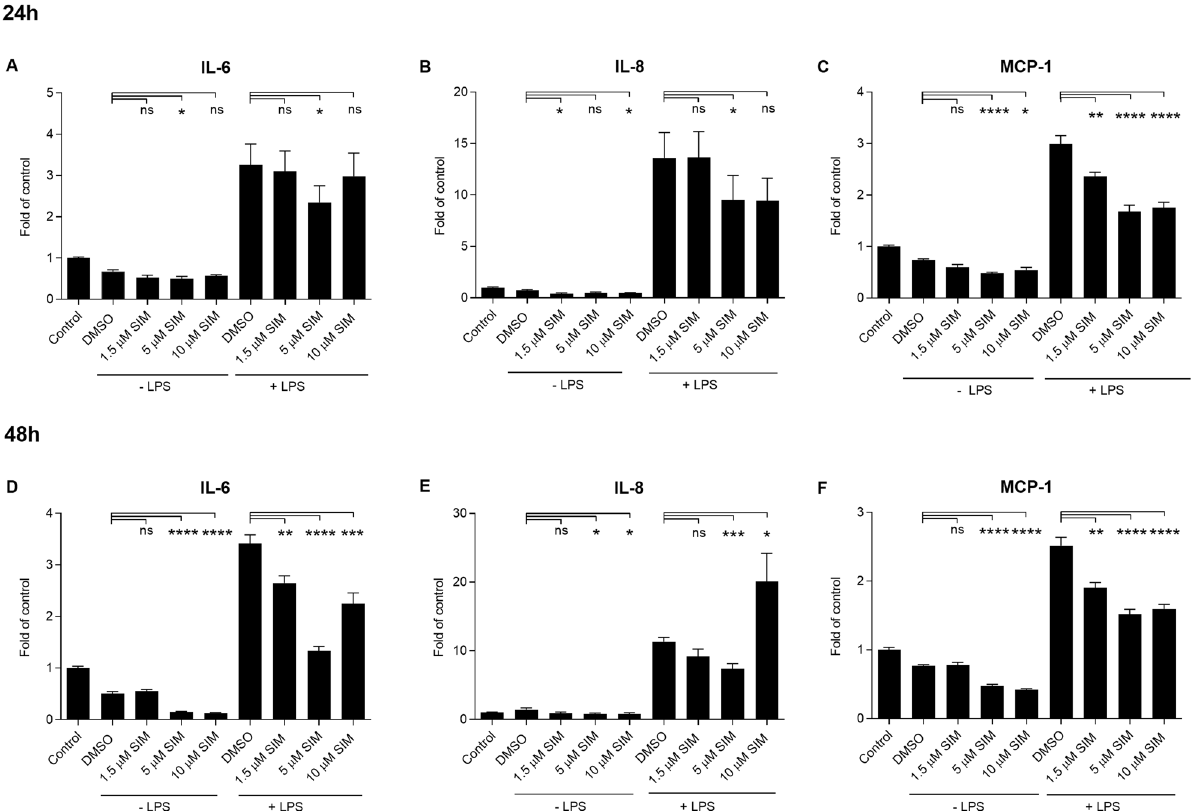
Figure 1. The effect of simvastatin (SIM) on the production of pro-inflammatory cytokines in human RPE cells. The levels of IL-6, IL-8, and MCP-1 were measured following the 24 h ( A – C ) or 48 h ( D – F ) exposure to SIM with or without additional exposure to LPS for 24 h. The results are represented as fold of control, which was set to be 1. Results are combined from 3 independent experiments with 4 parallel samples per group in each experiment ( A – C ) and from 4 independent experiments with 4 parallel samples per group in each experiment ( D – F ) and shown as mean ± standard error mean (SEM). *P < 0.05, **P < 0.01, ***P < 0.001, ****P < 0.0001, ns not significant, Mann–Whitney U